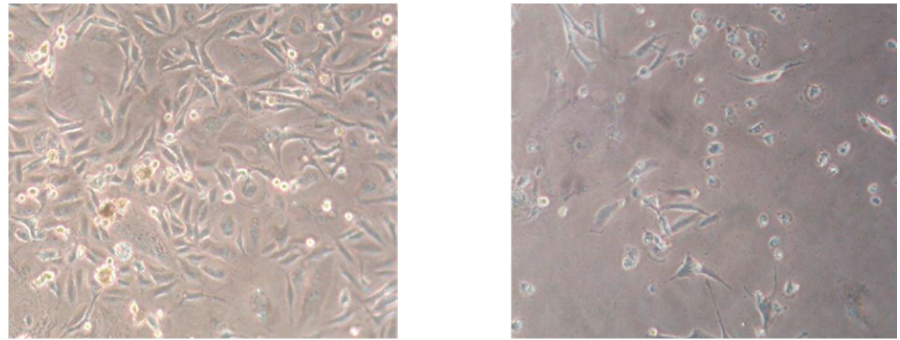
Figure 4. Control cells after 48 h ( left ), and cells after 48 h of incubation with compound 1 at 10 μ M concentration ( right ).